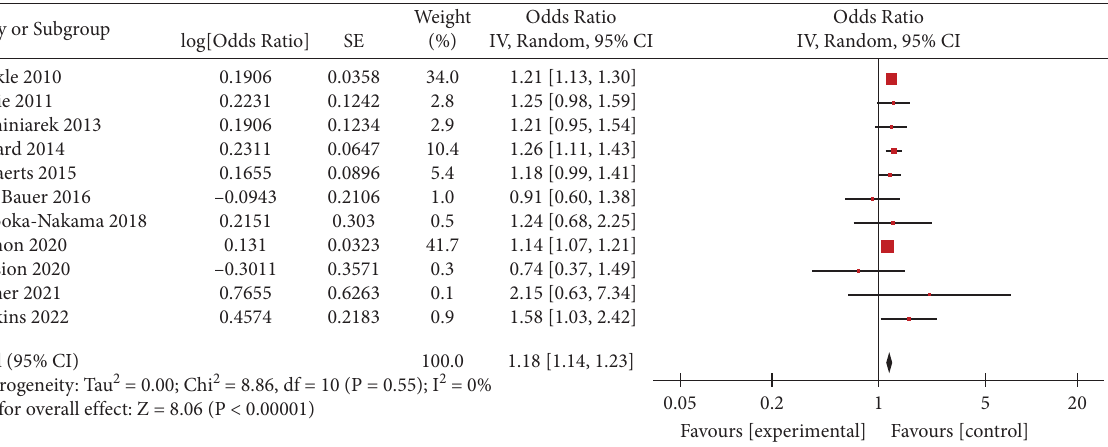
Figure 4: Forest plot of the association between inadequate weight in obese women and